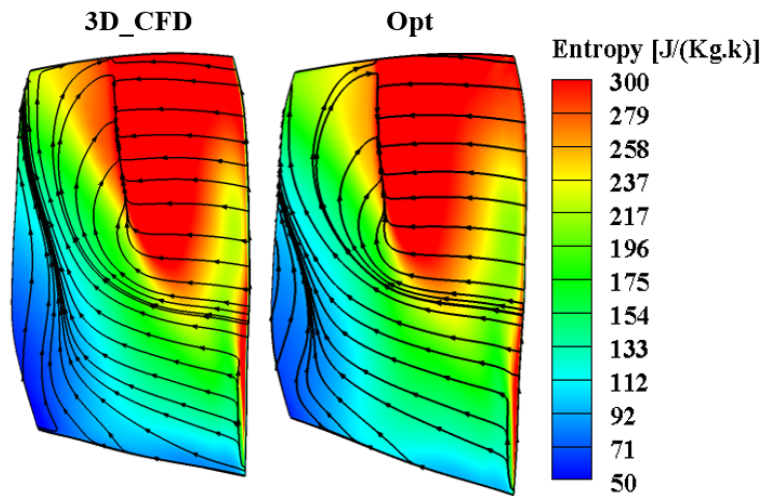
Figure 20. The distribution of entropy and skin-friction vector lines on the rotor1 suction surface.